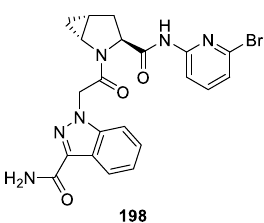
Figure 70. Chemical structure of 1 H -indazole derivative 198 .